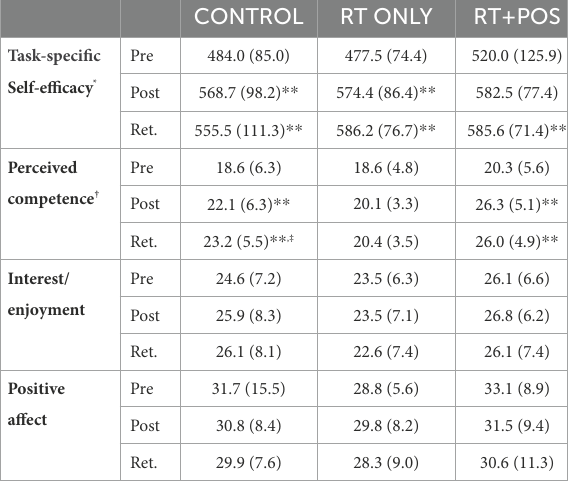
TABLE 2 Scores from expectancy measures across practice and at